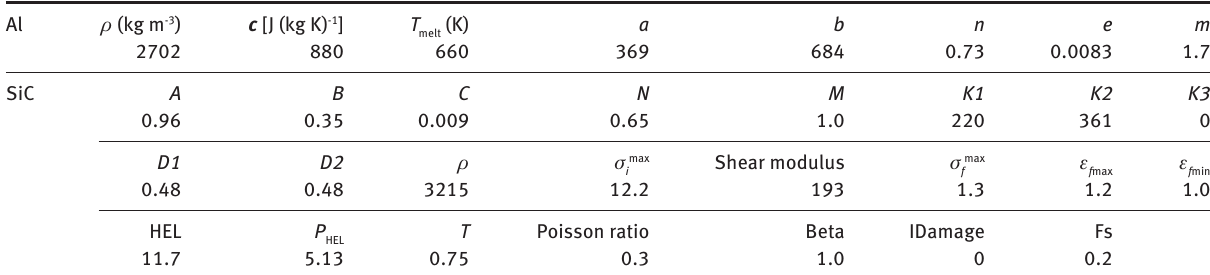
Table 1 Material parameters of Al and